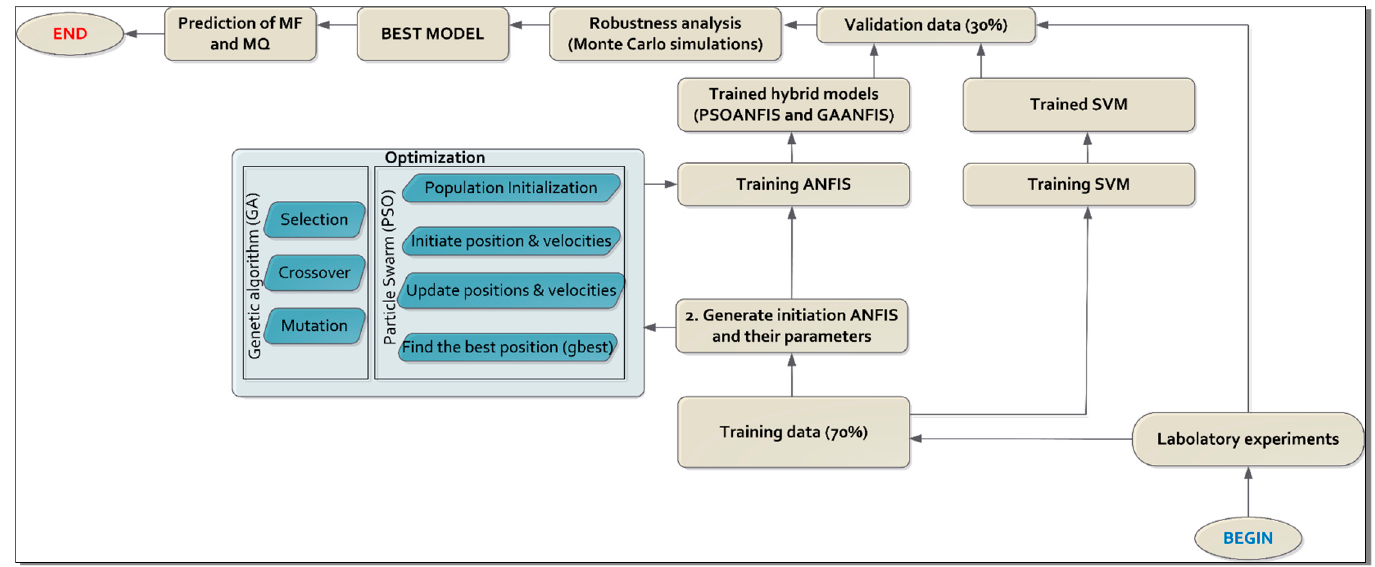
Figure 5. Methodological chart of the present study.